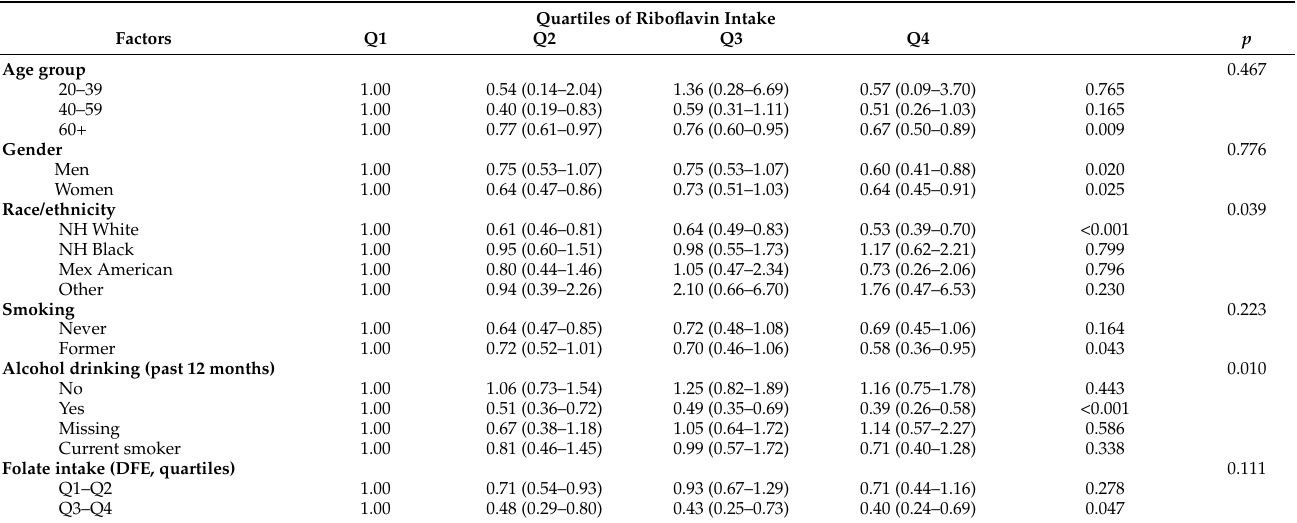
Table 4. Subgroup analyses of the association between quartiles of riboflavin intake and all-cause